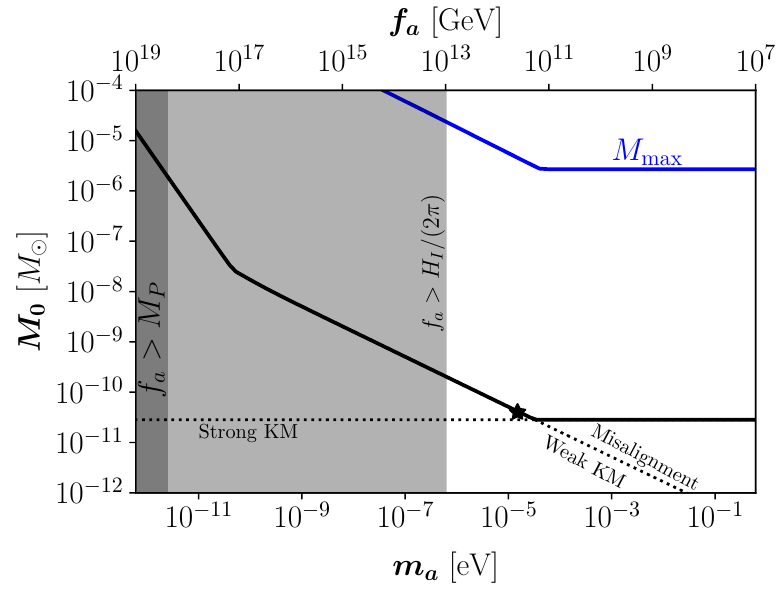
Figure 6. The characteristic minicluster mass, for δ = 1. The two dotted lines correspond to the cases of standard scenario or the weak KM regime, and to the strong KM